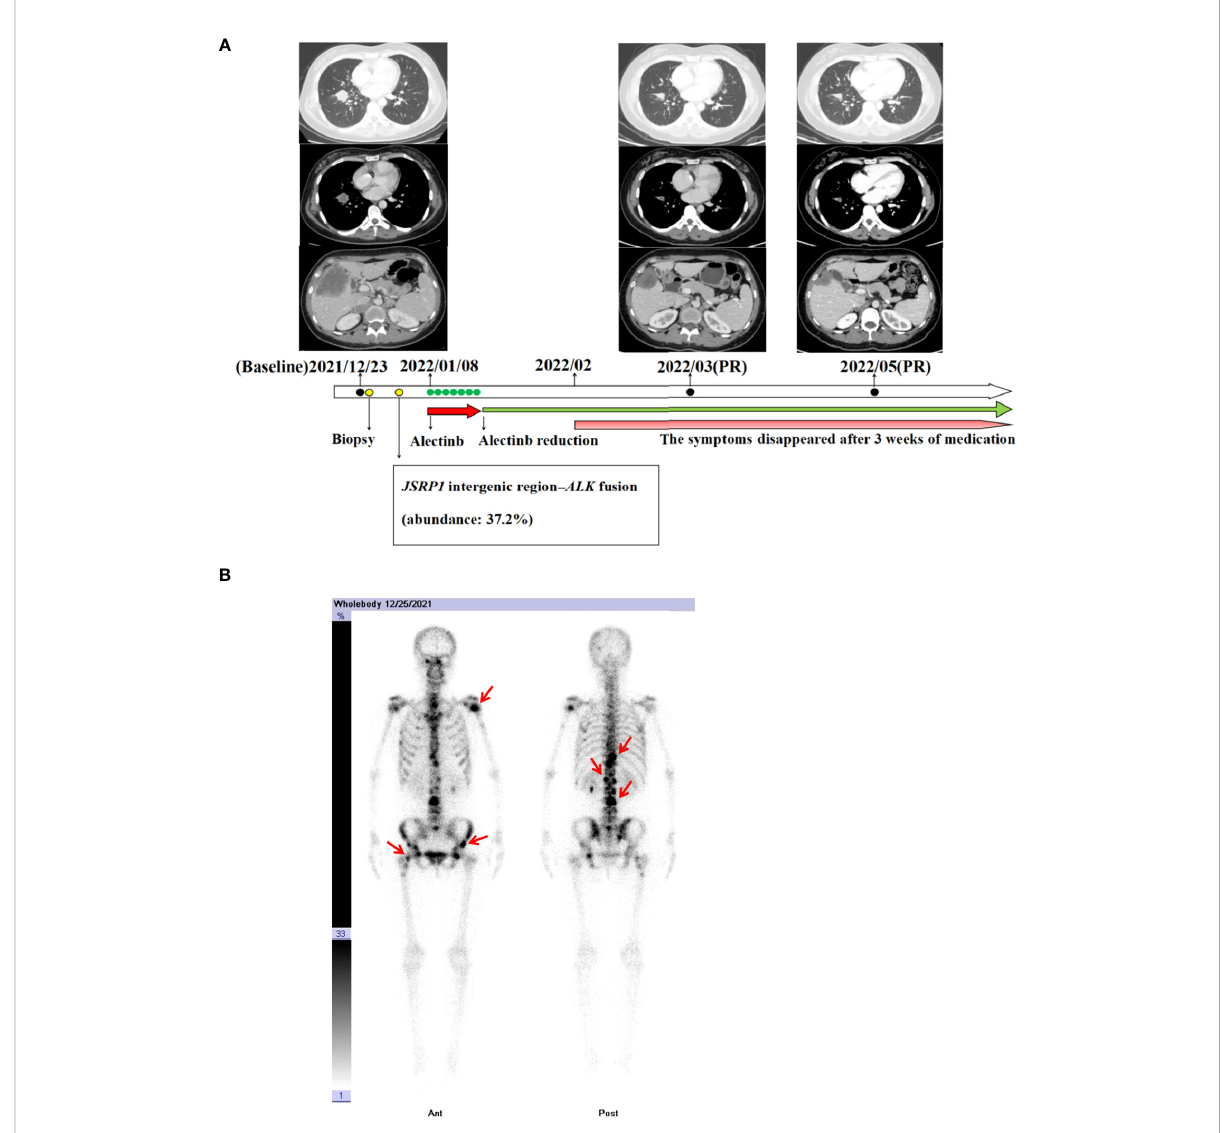
FIGURE 1 (A) Chest and abdomen computed tomography scans revealing the clinical response to alectinib. (B) Bone scan with technetium 99m-methyl diphosphonate prior to alectinib treatment revealing radioactive accumulation in the bones (red